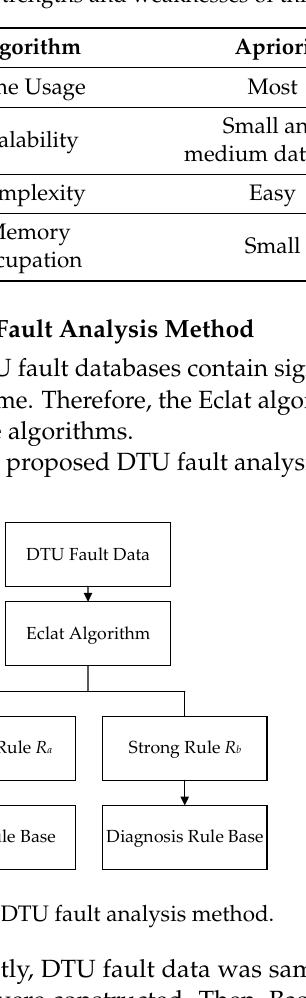
Table 4. Strengths and weaknesses of three algorithms.